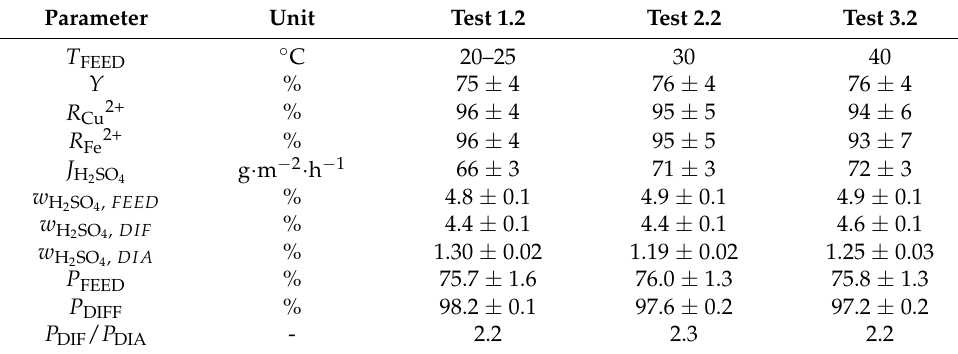
Table 4. Summarized values of performance parameters used for Tests 1.2, 2.2, and 3.2. Symbols: T FEED —temperature of feed, Y —yield of acid, R Cu2+ —rejection of Cu 2+ , R Fe2+ —rejection of Fe 2+ , J H —flux of acid, w H —weight fraction of acid in feed (diffusate/dialysate) 2 SO 4 2 SO 4 , FEED ( DIF / DIA )